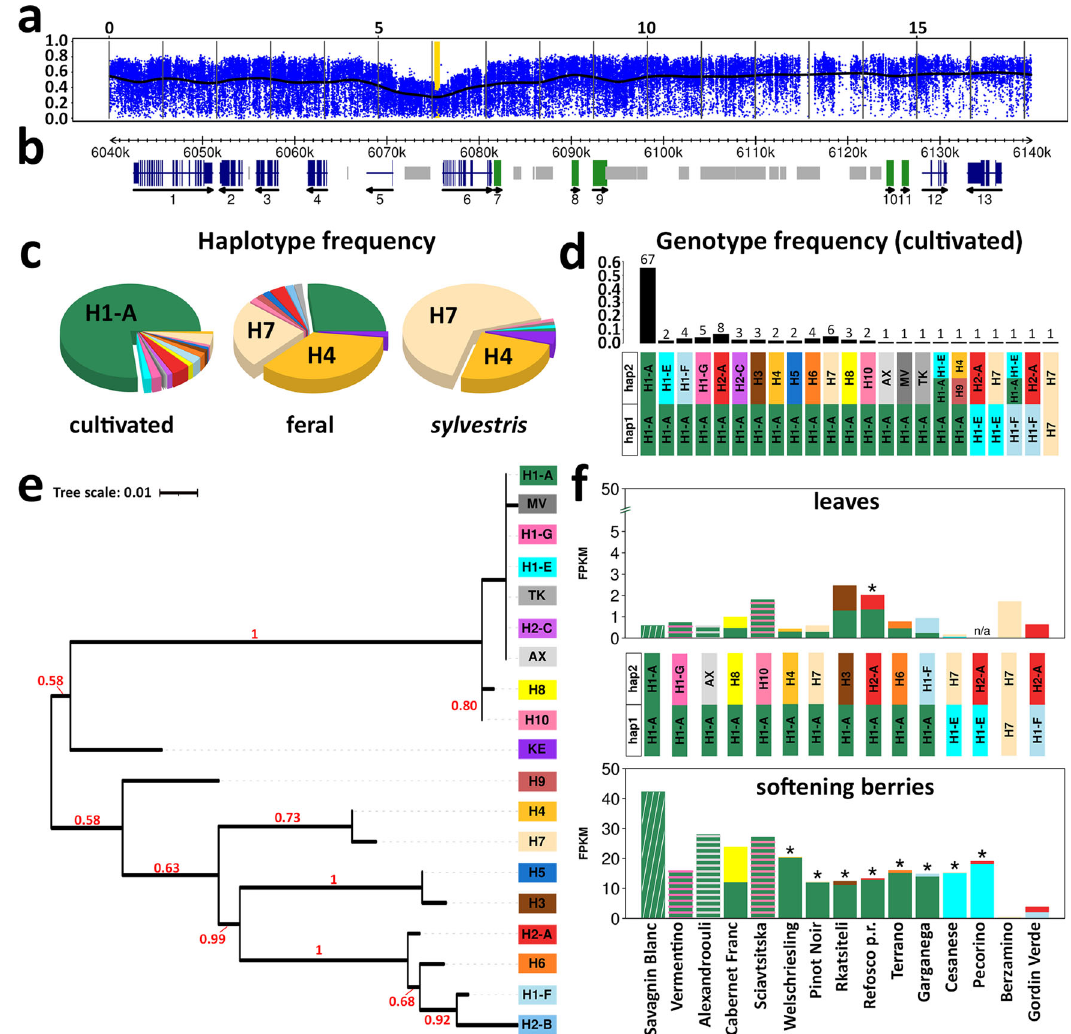
Fig. 5 Selective sweep on chromosome 17 and allele speci fi c expression (ASE) of the LRR – receptor kinase VIT_217s0000g05570 . a Chromosomal plot of haplotype diversity. Haplotype diversity was calculated in blocks of fi ve consecutive variant sites and plotted as the average of 50 consecutive blocks (blue dots) and a cubic smoothing spline (black line). The scale indicates Mb. The yellow background indicate the interval magni fi ed in b . b V2.1 gene models (exons in blue), manually curated gene predictions (green) in the isopiperitenol/carveol dehydrogenase gene cluster (gene IDs 7 → 11), annotated transposable elements (light gray). c Frequency of 19 haplotypes shown in Supplementary Fig. 38 in 196 grapevine accessions. d Genotype frequency in